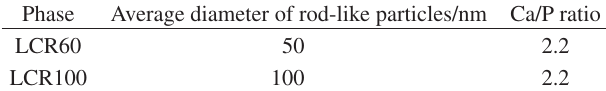
Table 1. Average diameter and Ca/P ratio for HAP rod-like particles.